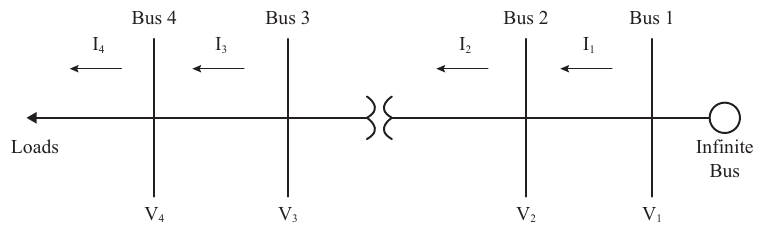
Figure 1. Illustration of the IEEE 4-bus